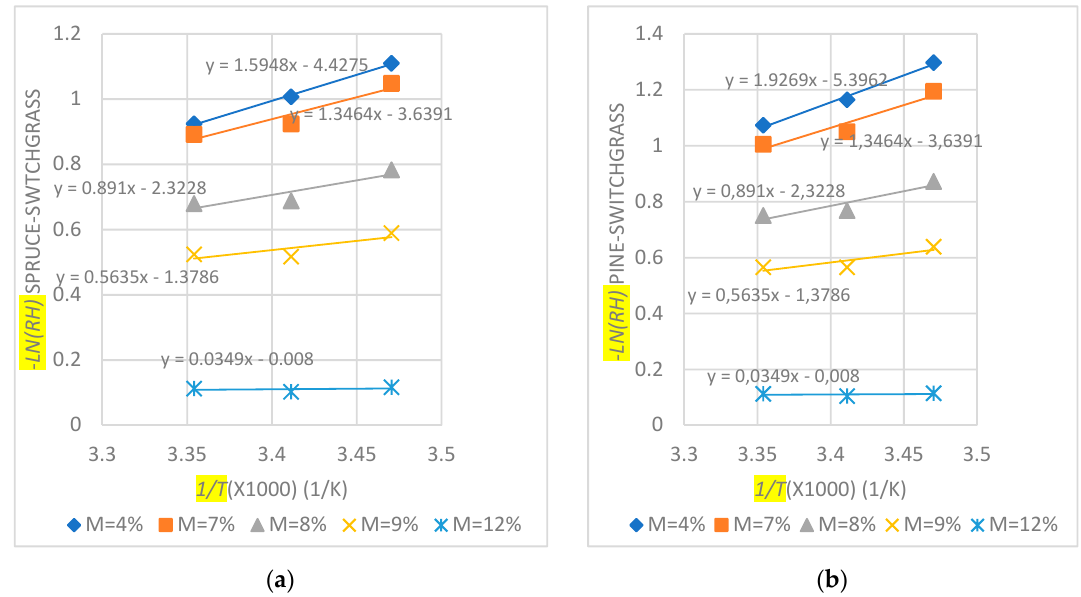
Figure 4. Determination of net isosteric heat of sorption for the mixed pellets. ( a ): spruce–switchgrass and ( b ): pine–switchgrass.